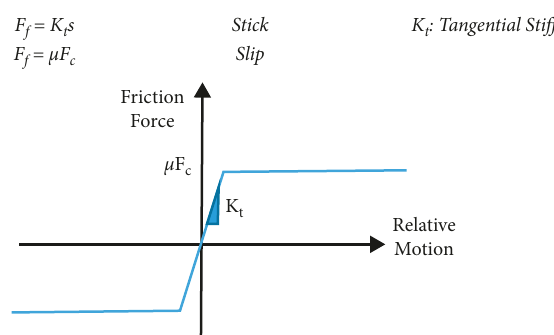
Figure 15: Elasto-perfectly plastic model.